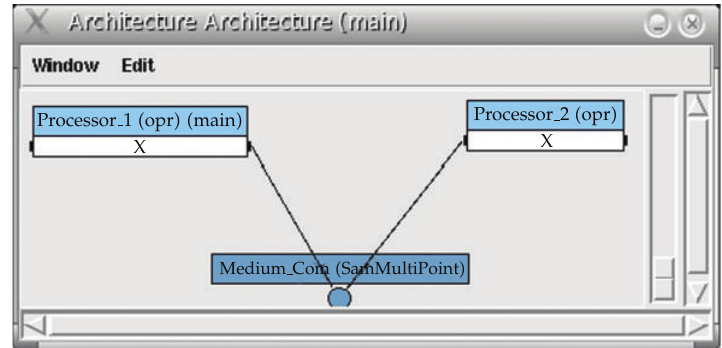
Figure 5: Platooning application (cid:3) architecture graph (cid:4) .